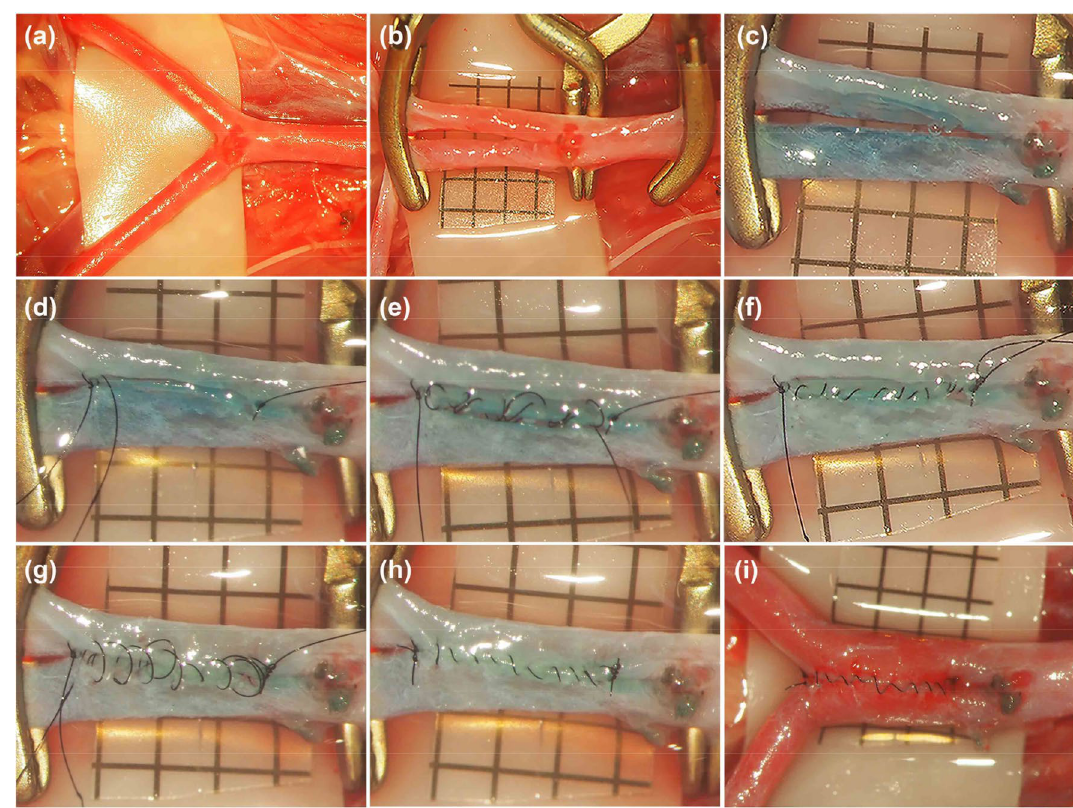
Figure 5. Side-to-side anastomosis of bilateral common iliac arteries. After both common iliac arteries were dissected ( a ), the caudal artery was temporarily clipped, the bilateral common iliac arteries were drawn close to each other and temporarily clipped ( b ). Arteriotomies of approximately 3 times the diameter of the common iliac artery were performed on both arteries ( c ), two anchoring stitches were placed on both opposite side of the anastomoses ( d ), the posterior wall was closed intraluminally in a loose continuous suturing technique ( e ) and these sutures were tightened ( f ), and the anterior wall was closed extraluminally in a loose continuous suturing technique ( g ) and these sutures were tightened ( h ), and the blood flow was restored ( i ) after the temporary clips were removed. (Scale bar = 1